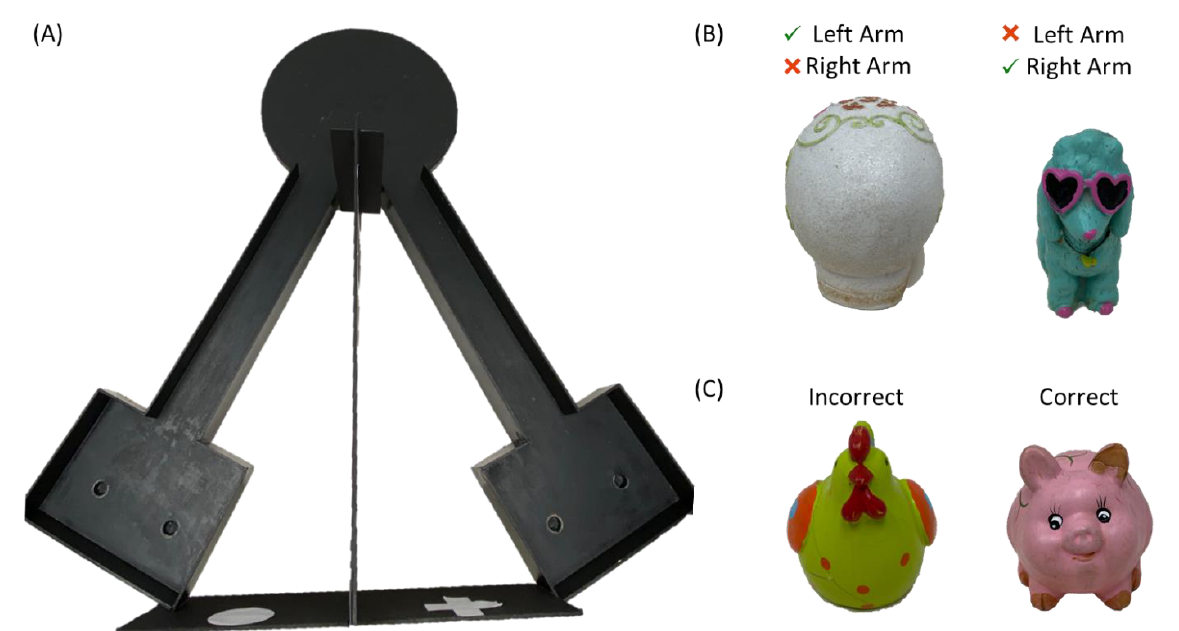
Figure 1. Behavioral testing apparatus and objects utilized for BAT and object discrimination tasks. ( A ) Birds-eye view of the testing apparatus used for alternations, BAT, and object discrimination tasks. Note during the object discrimination, only one arm of the maze was used, and rats were not required to alternate. Objects utilized during ( B ) BAT. In the left arm of the maze the white skull was rewarded when selected while the blue poodle was the correct in the right arm. Thus, the correct response updated based on spatial location. Objects used for ( C ) simple object discrimination test- ing. The pig was the correct choice.